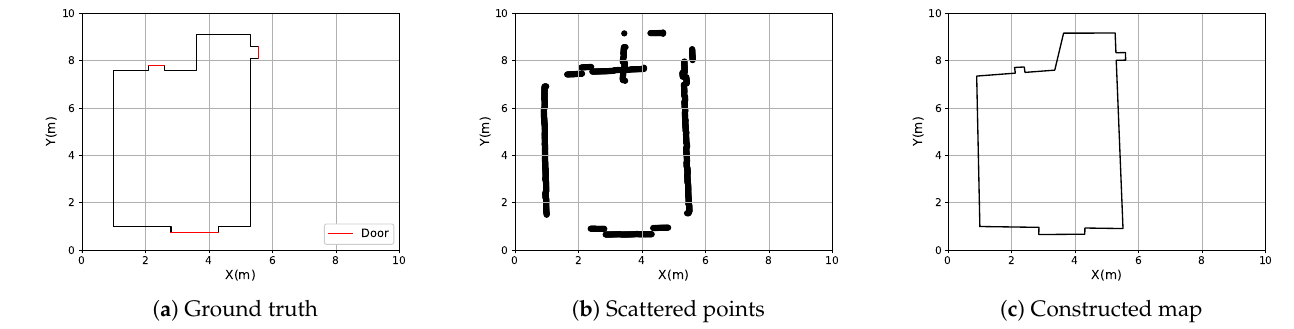
Figure 12. Living room construction process. ( a ) represents the real indoor plan. ( b ) repre- sents the collected wall coordinate points. ( c ) represents the indoor plan constructed by the map refinement algorithm.